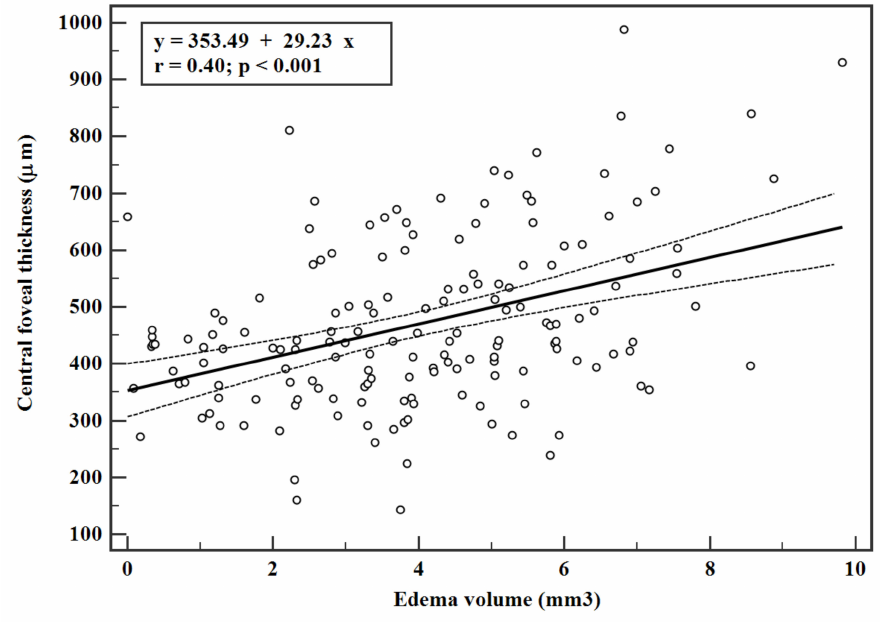
Figure 1. Linear regression with 95% confidence interval between central foveal thickness and edema volume. Only eyes with an edema volume greater than zero were included in the regression. Thickness was derived from the central sector of the ETDRS